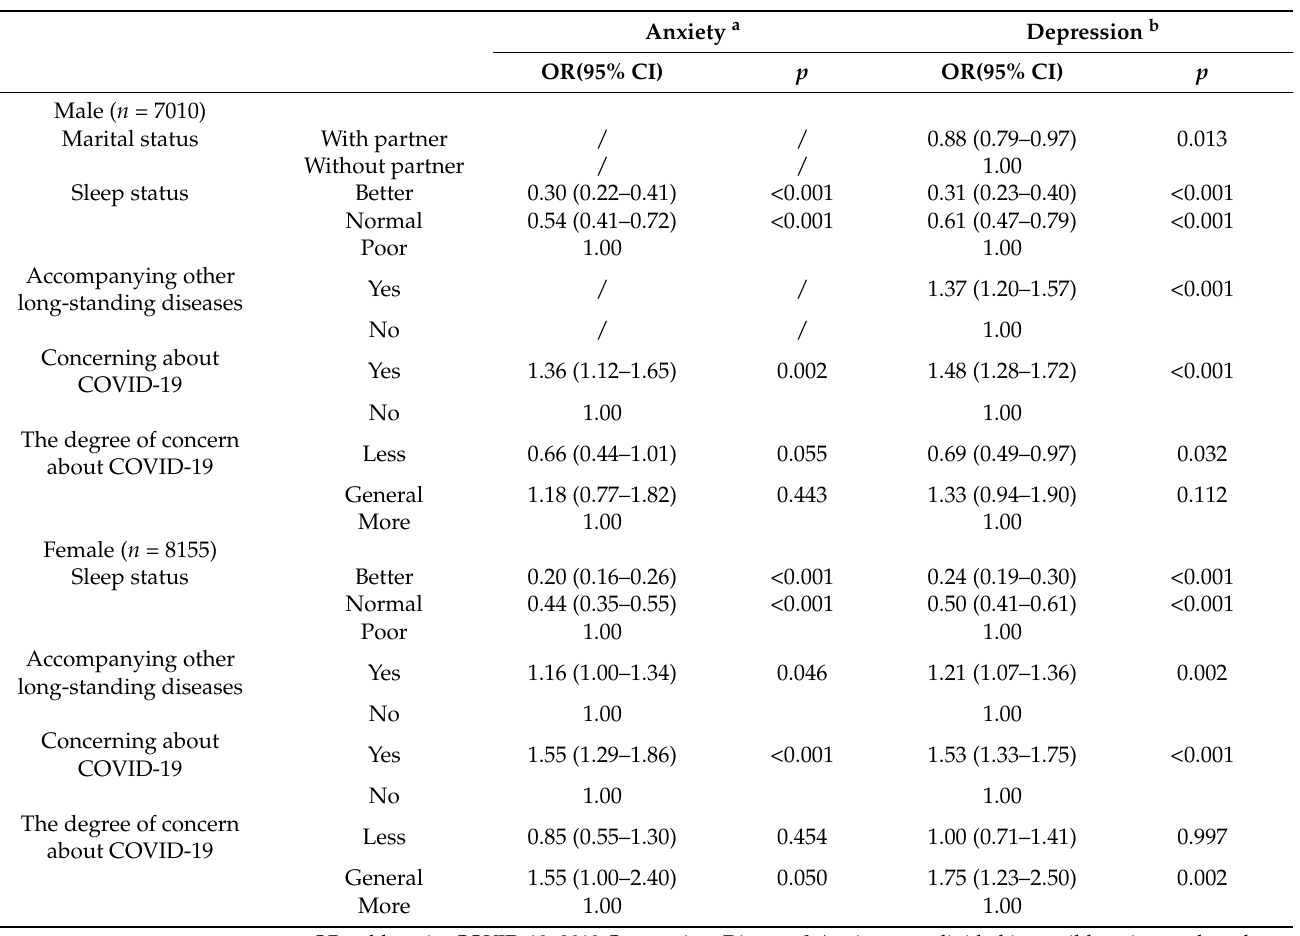
Table 5. Logistic regression analysis of anxiety and depression in male and female patients with schizophrenia in the